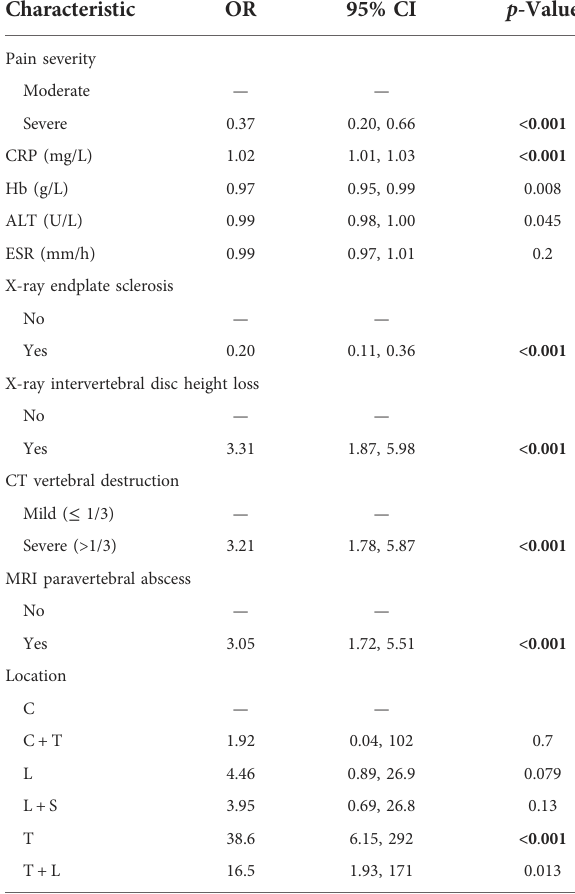
TABLE 2 Prediction factors for TS from study population by multiple logistic regression model.